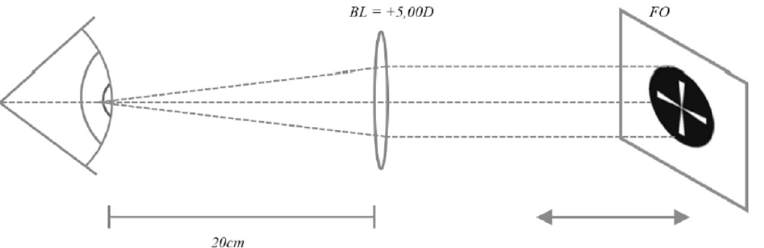
Fig 1. The Badal lens system used for measuring the accommodative response with constant angular size of the object. The +5.0 D Badal lens was placed 20 cm from the eye’s nodal point. A movable fixational object (FO) was used to stimulate accommodation at different